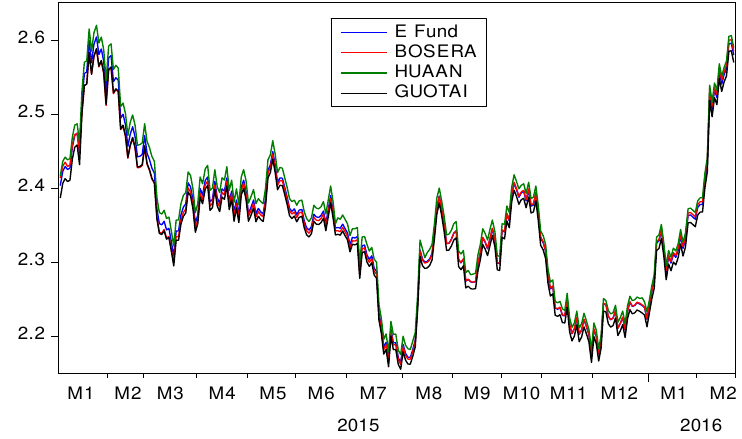
Fig. 1. Performance of the four gold ETFs in China, March